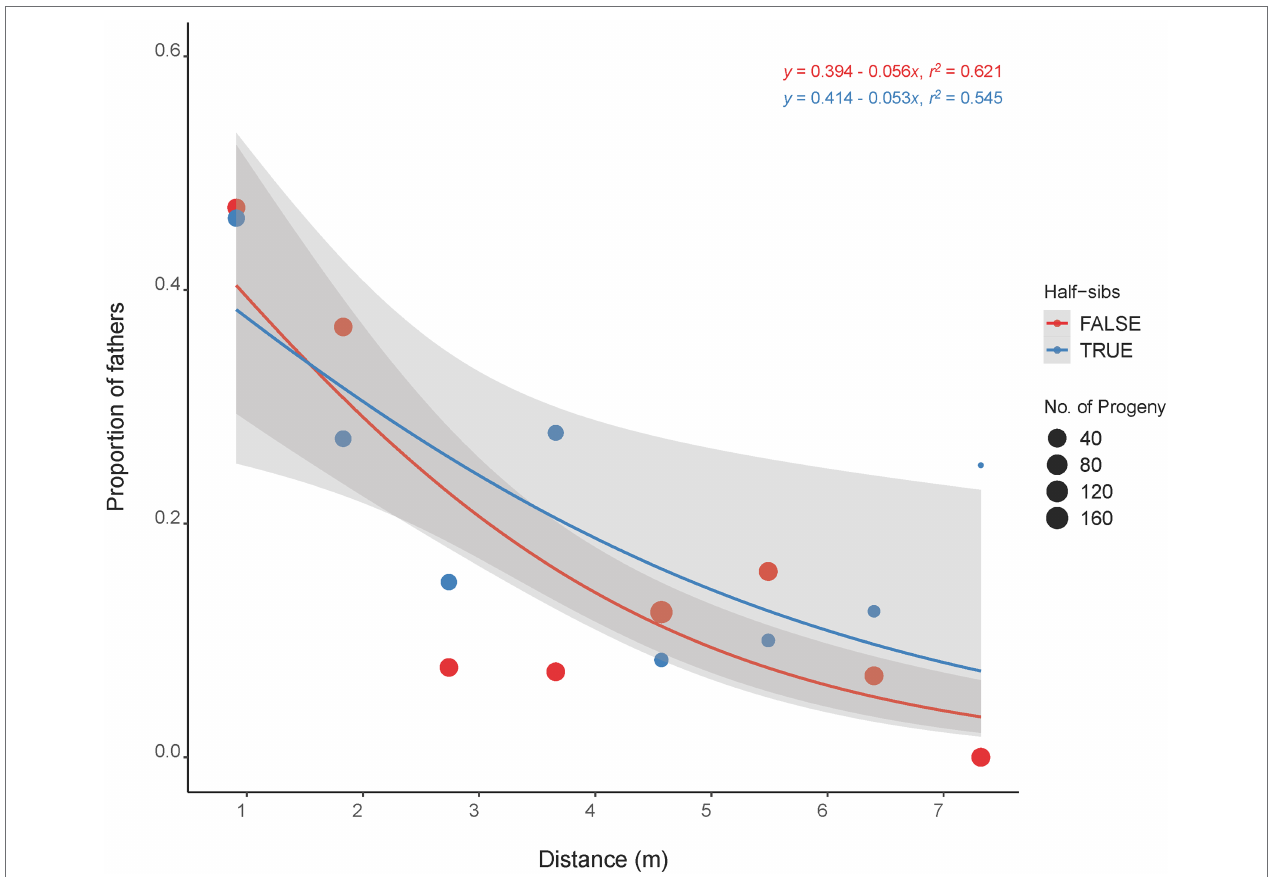
FIGURE 4 | Distance of mother plants that were pollinated by their half-sibs (blue line) and non-half-sibs (red line). Dot sizes are proportional to the total number of progeny fathered by the father plants located at specific distance from the mother plants. Shaded regions are standard error estimates of the distribution at 95% confidence interval.